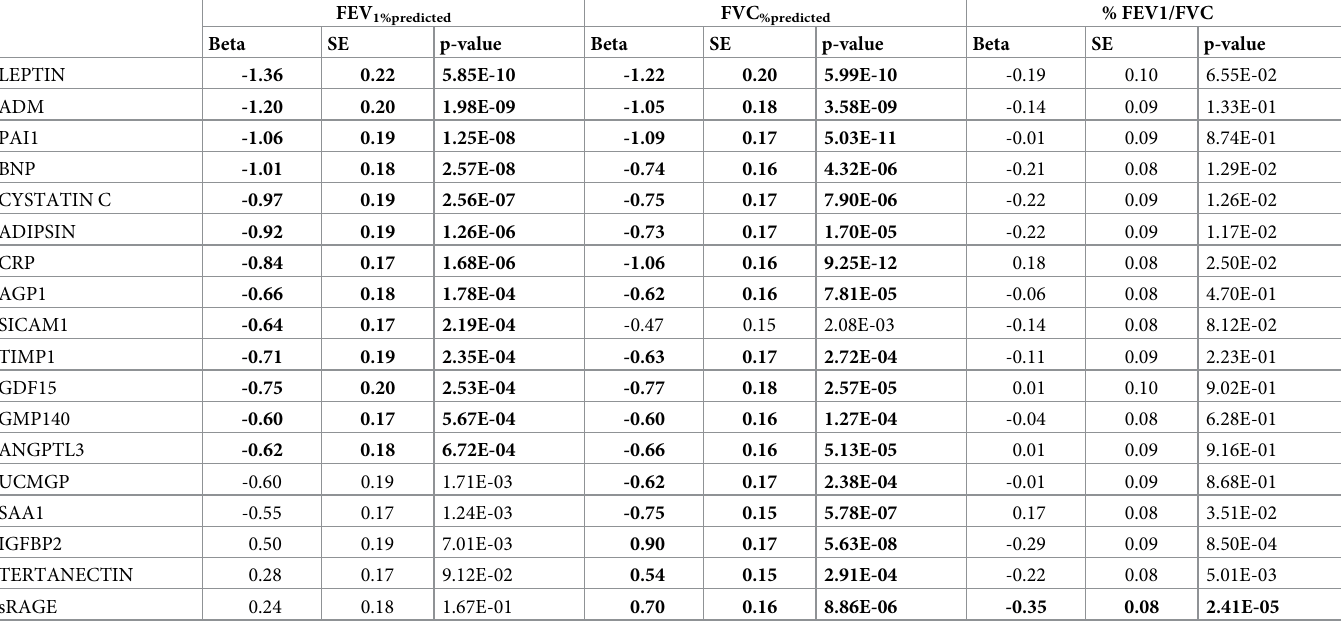
Table 2. Cross-sectional associations of proteins at baseline with FEV 1%predicted , FVC %predicted , and FEV 1